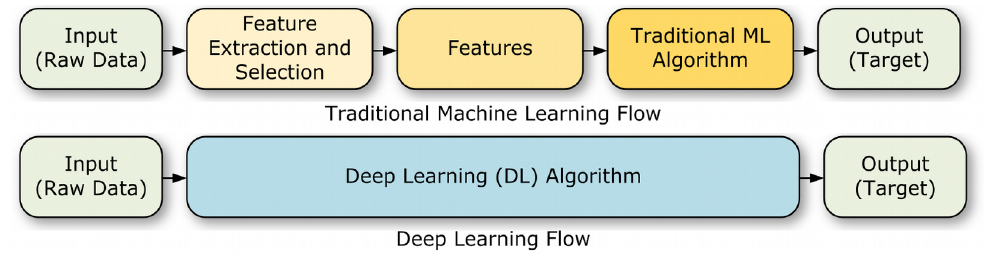
Figure 1. FD/D flows of traditional ML and DL based